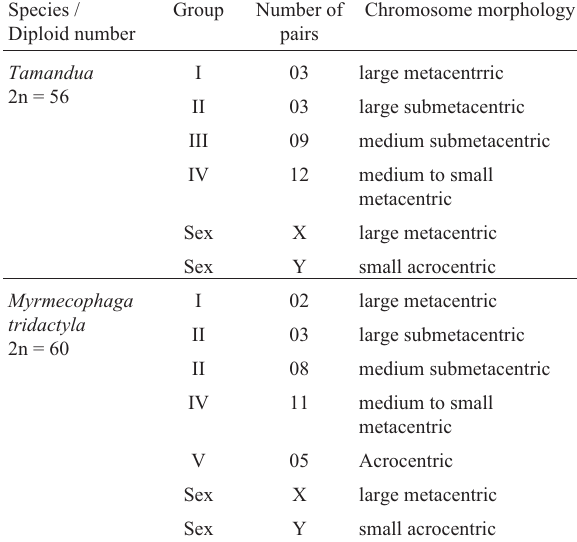
Table1 -Chromosomeconstitutionoftheanteatersanalyzedinthisstudy, according to diploid number, number of pairs per group and chromosome morphology.